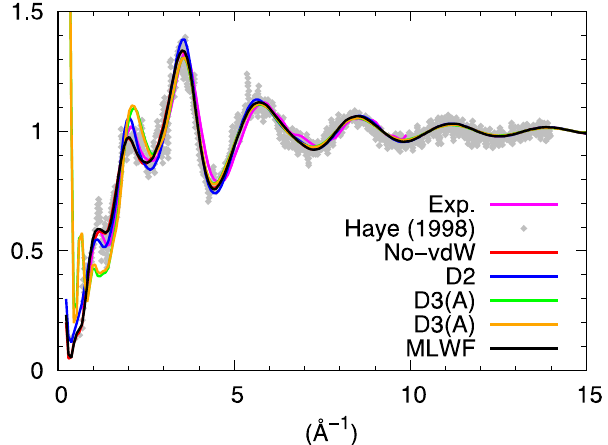
Figure 5. Total neutron structure factor of liquid GeSe 4 . The experimental data are those of Ref. [27]. Haye (1998) stands for Ref. [27].